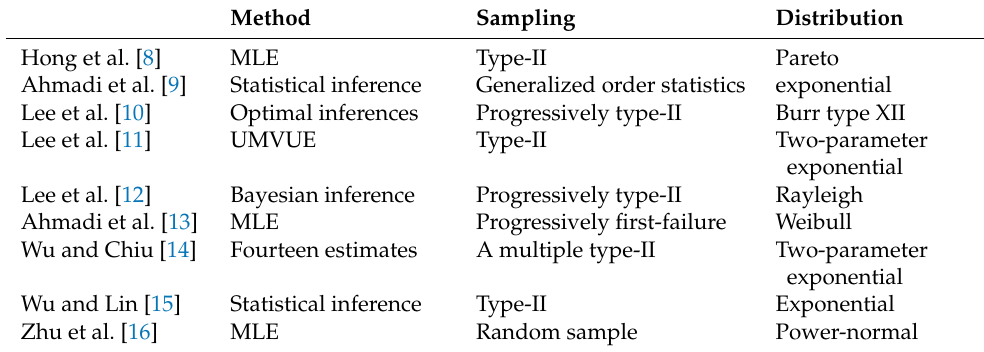
Table 1. Summary of estimation methods for process performance